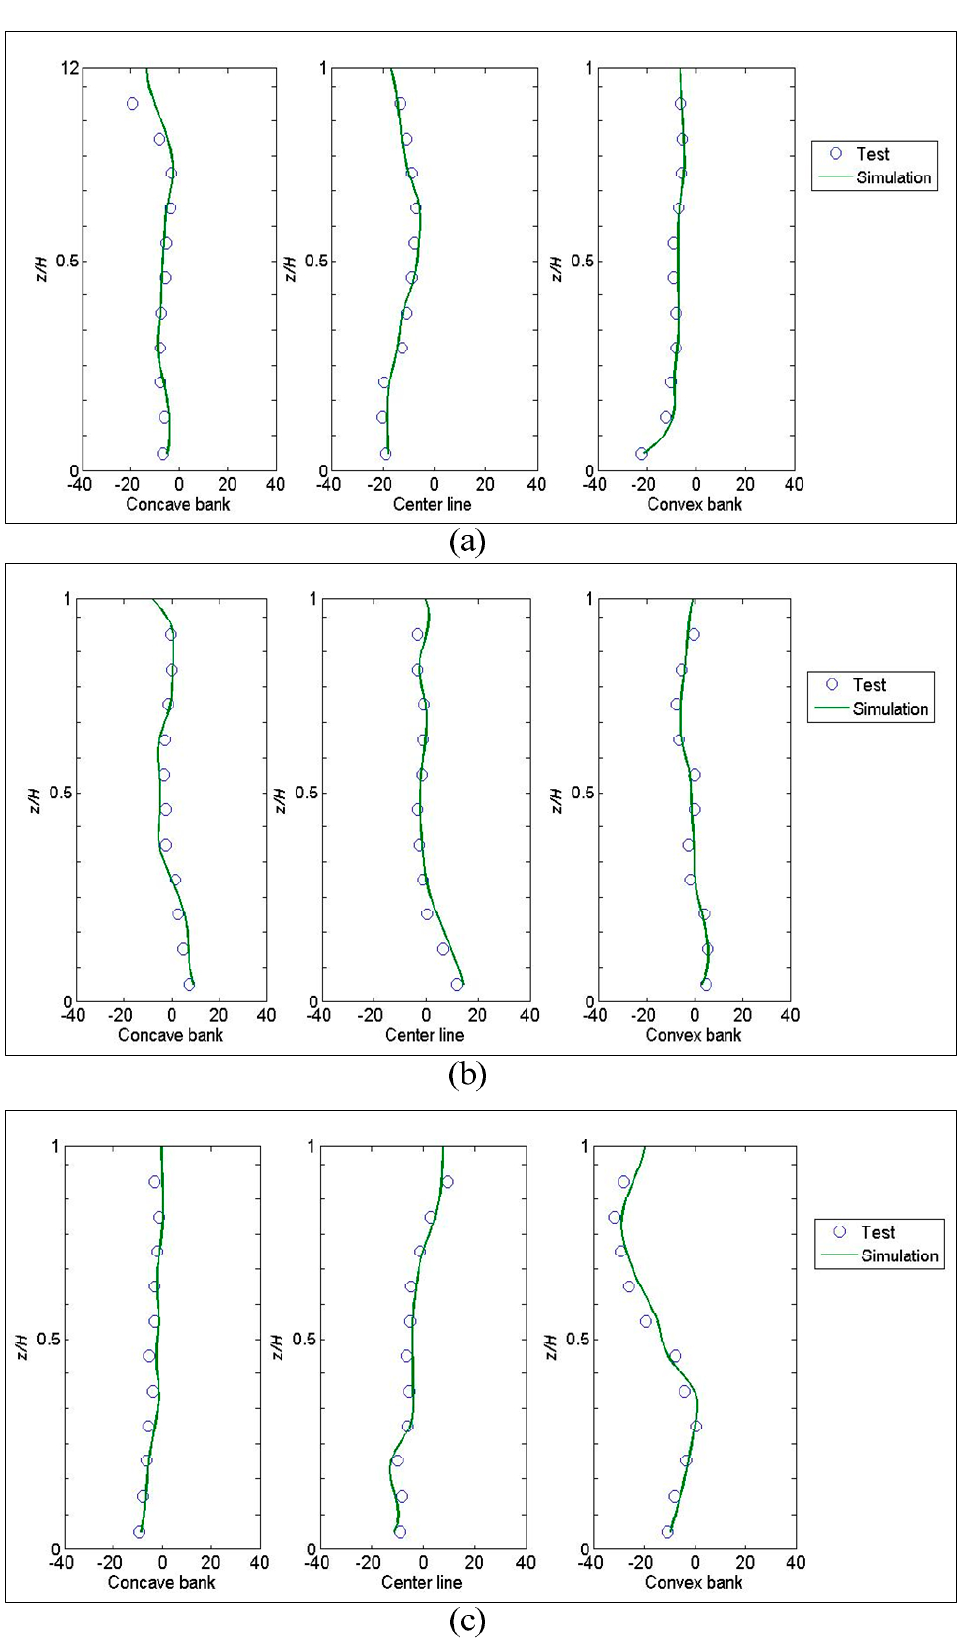
Figure 7. Reynolds stresses − 10 4 ρ u (cid:48) w (cid:48) / U 2 along vertical line for sections: ( a ) D45; ( b ) D90; ( c ) D135.